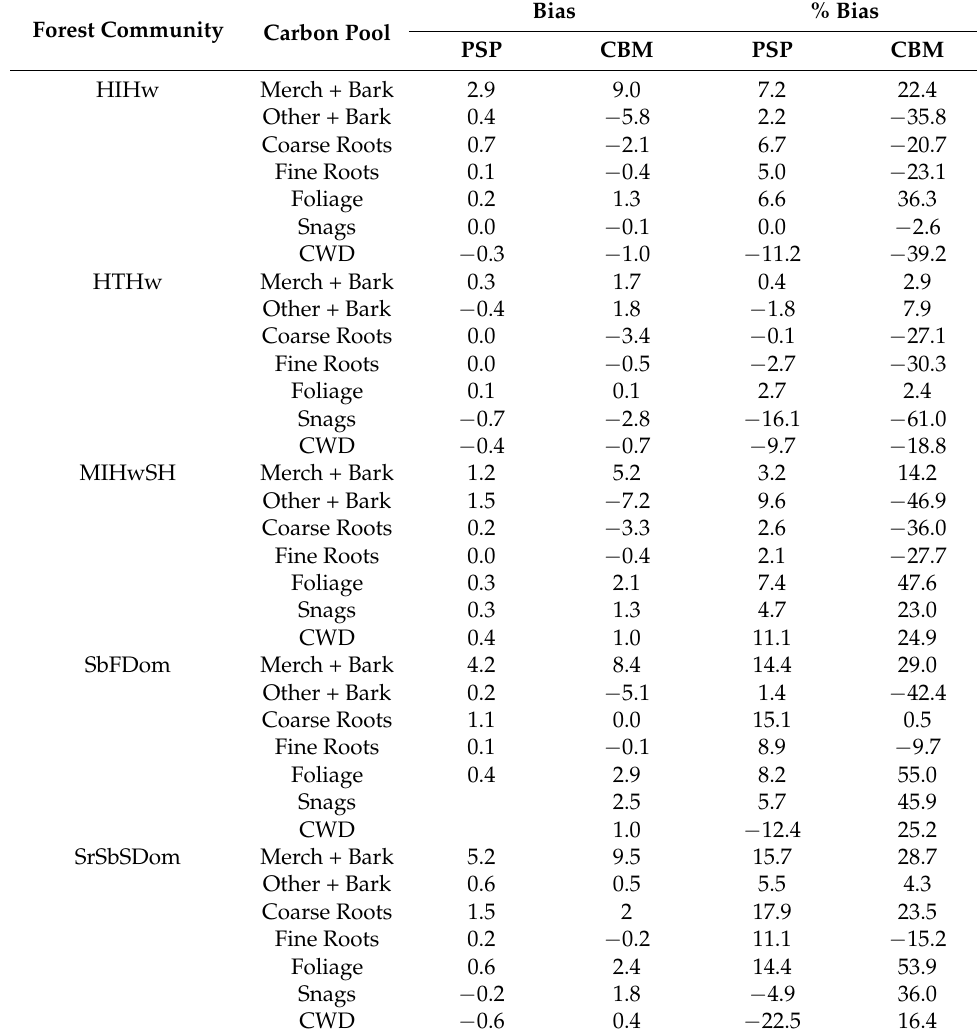
Table A3. Bias and Percent Bias of both estimation methods against an independent PSP dataset ( n = 100 per community), by forest community and carbon